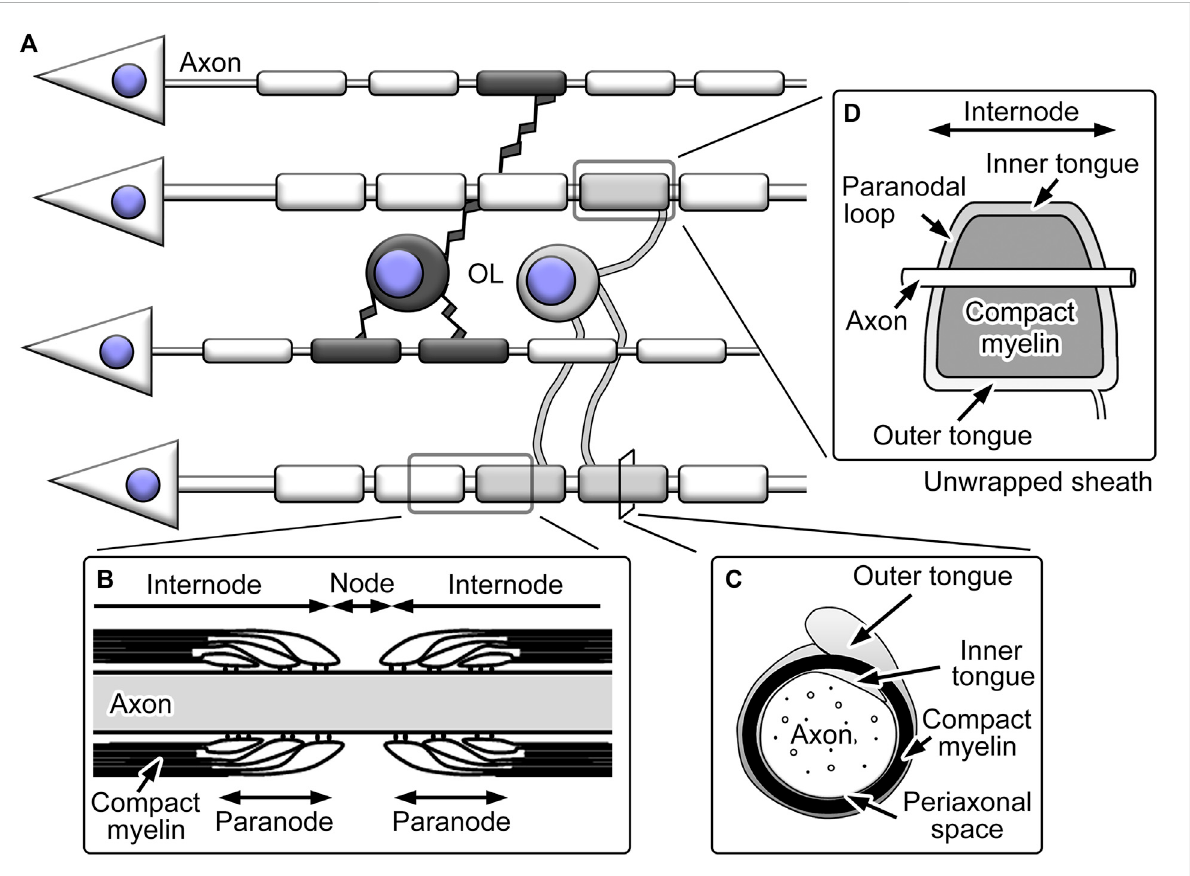
FIGURE 2 Schemes showing structures of oligodendrocytes (OL) and their myelin. (A) OL typically extend multiple processes and form myelin ensheathmentaround neuronal axons. (B) The axons with myelin ensheathmentcanbedividedintonodes ofRanvier and internodes. The nodes are fl anked by paranodes with paranodal loops and transverse bands. (C) The internodal myelin sheaths include compact myelin with inner and outer tongues of cytoplasmic channels, and the periaxonal space represents the space between axolemma and adaxonal membranes of oligodendrocytes. (D) When the internodal myelin sheaths are unwrapped, the inner and outer tongue processes; the latter is connected to the process from the cell body, continues throughout the internode and is connected with the paranodal